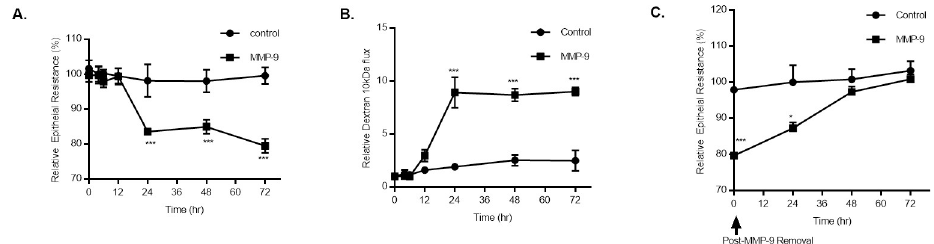
Fig 1. Time-course effect of MMP-9 on Caco-2 intestinal epithelial TJ permeability. (A) Time-course effect of MMP-9 (400 ng/ml) on Caco-2 TER and (B) mucosal-to-serosal flux of paracellular marker dextran 10 kDa (n = 4). ��� P < 0.001 vs control. The effect of MMP-9 on Caco-2 TER and paracellular permeability were measured over a 72-hr experimental period. (C) Effect of recovery after MMP-9 treatment cessation on Caco-2 TER (n = 4). ��� P < 0.001 vs control; � P < 0.05 vs control. Filter-grown Caco-2 monolayers were refreshed with control media after MMP-9 experimental period